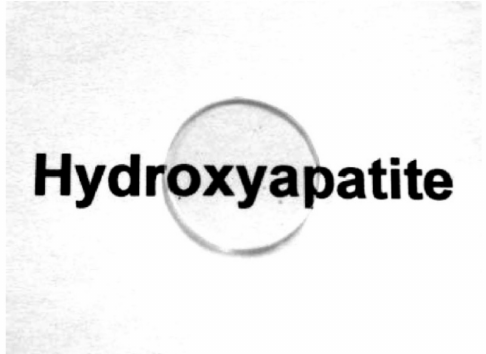
Figure 6. Transparent HA bioceramics prepared by spark plasma sintering at 900 ◦ C from nanosized HA single crystals. Reprinted from Ref. [419] with